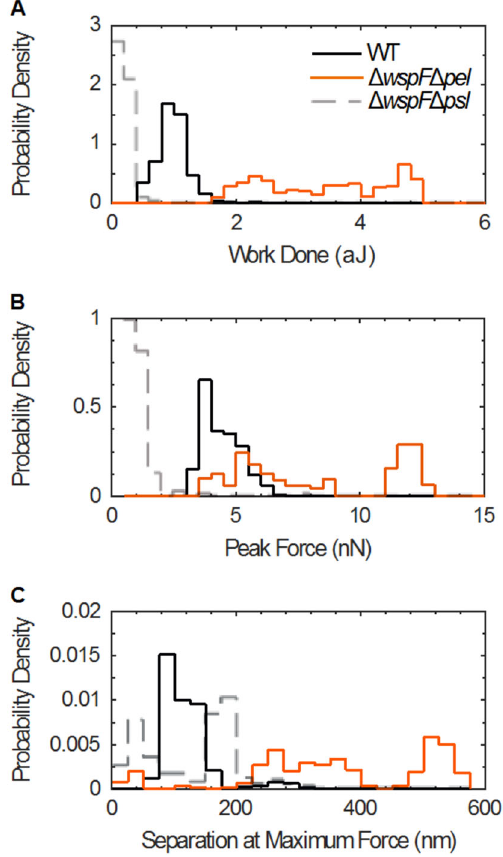
Fig. 3 Increased Psl production increases inter-bacterial cohesion. ( a ) Numerical integration of AFM force-displacement curves gives the net mechanical work of detachment. The work for Δ wspF Δ pel ( solid orange line ) is ~4× greater, on average, than for WT ( solid black line ) and ~10× greater than for Δ wspF Δ psl ( dashed grey line ). ( b ) The peak force is the maximum force measured for each detachment curve. Peak forces for Δ wspF Δ pel are greater than for WT and Δ wspF Δ psl . ( c ) The separation at maximum force is the displacement at which the peak force is found, and is greater for Δ wspF Δ pel than for WT and Δ wspF Δ psl . The rate of retraction of the AFM cantilever for the data shown here is 1 μ m/s. The trends shown here agree with the trends found when the retraction rate is 10 μ m/s (Fig. S9). ( n =